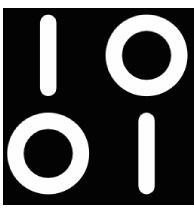
Figure 2. The Betti numbers of a binary image. By convention, a binary image represents the cubical complex X of white pixels in the image. Its Betti numbers are β 0 ( X ) = 4 and β 1 ( X ) = 2. Note that if the image is surrounded by a boundary of white pixels, then β 0 ( X ) = 5 and β 1 ( X ) = 3. Reproduced with permission from [32]; published by IEEE,